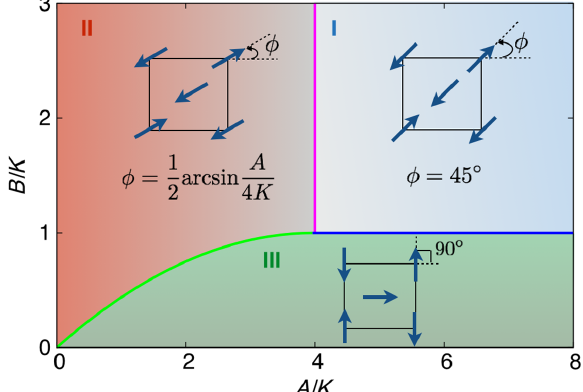
FIG. 2. Ground-state phase diagram of the model described in Sec. V, including the single-layer Heisenberg-compass terms of Eq. (5) plus the effect of interlayer (isotropic and anisotropic) exchange. The in-plane coupling constants are taken as obtained in the ab initio CI þ SOC calculations, while the effective interactions A , B , and K are defined through Eqs. (10) – (12); see